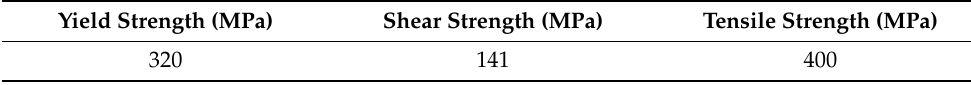
Table 4. Mechanical properties of carbon steel bolts taken from Ref.